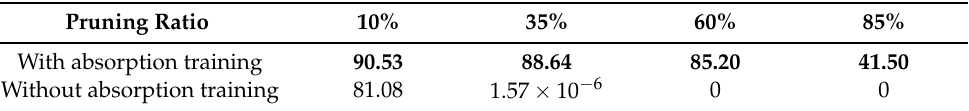
Table 2. Comparison of pruned network detection accuracy with and without absorption training under different filter pruning ratios (without